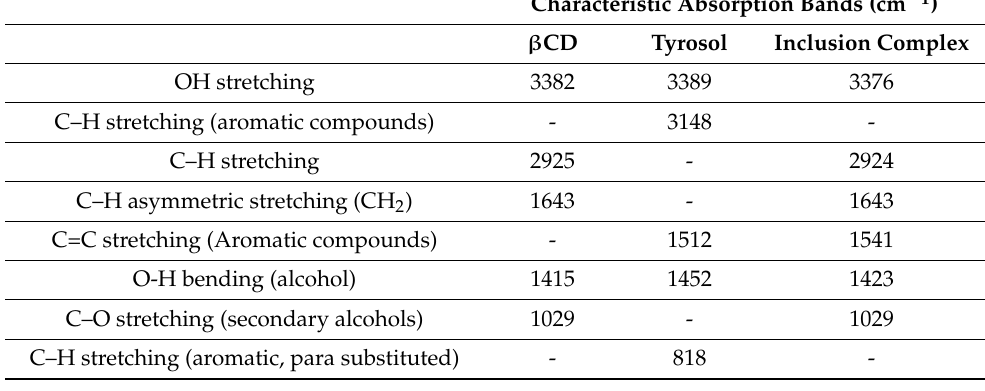
Table 7. Characteristic FT-IR absorption bands of β -CD, tyrosol and the tyrosol- β -CD inclusion com- plex.